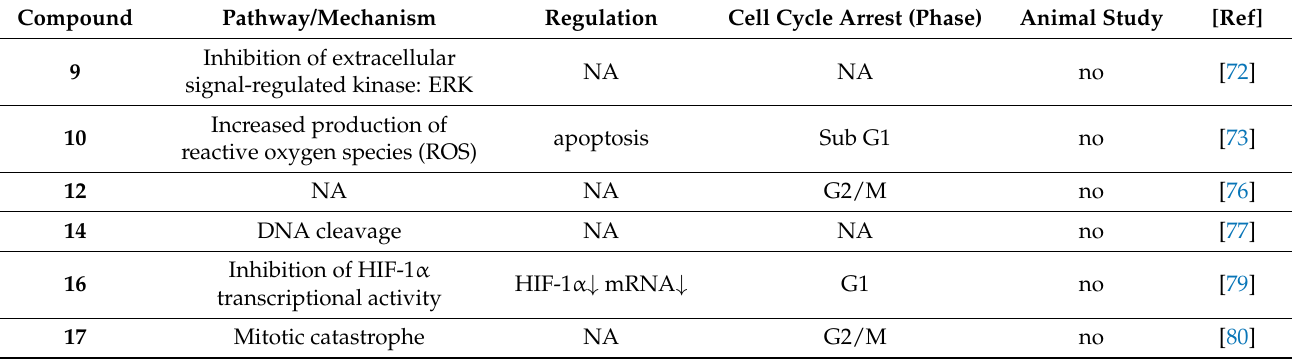
Table 2. Summarized information on UA analogs (C28 modifications).